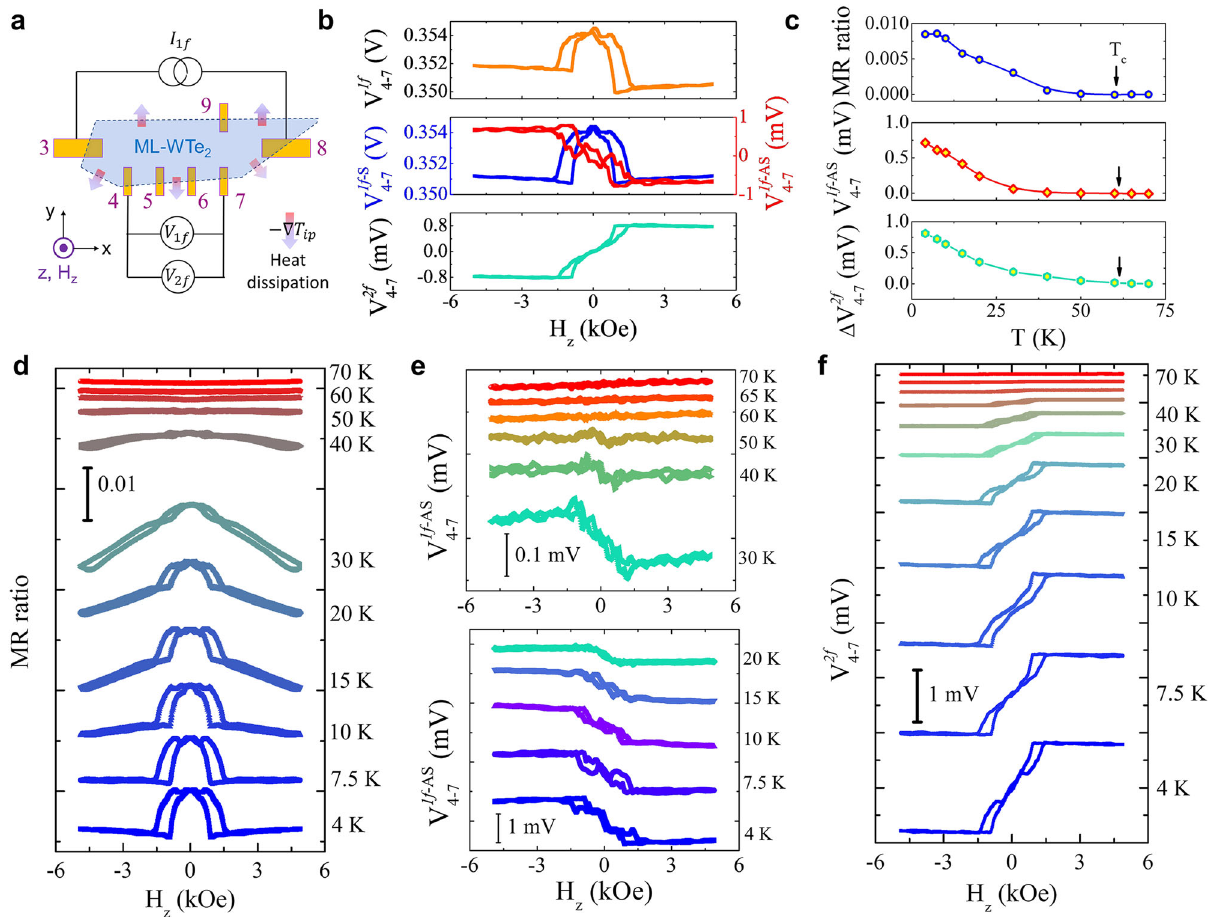
Fig. 2 | Temperature dependence of linear and non-linear responses in ML- WTe 2 /Cr 2 Ge 2 Te 6 heterostructure. a Schematic illustration of measurement geo- metry. An AC current of 3 μ A fl ows in the ML-WTe 2 fl ake through channel 3 – 8 (x- direction), and the 1 f and 2 f voltage responses are measured from channel 4-7 in sweeping H z with f =13Hz here. The thick arrows with color gradient across the deviceboundaryindicatethedirectionofheatdissipation,i.e., (cid:1) ∇ T ip ,where ∇ T ip is thein-planecomponentofthetemperaturegradient. b Magnetic fi elddependence of the raw 1 f , V 1 f 4 (cid:1) 7 (top), 1 f H z -symmetric, V 1 f (cid:1) S 4 (cid:1) 7 and H z -antisymmetric, V 1 f (cid:1) AS 4 (cid:1) 7